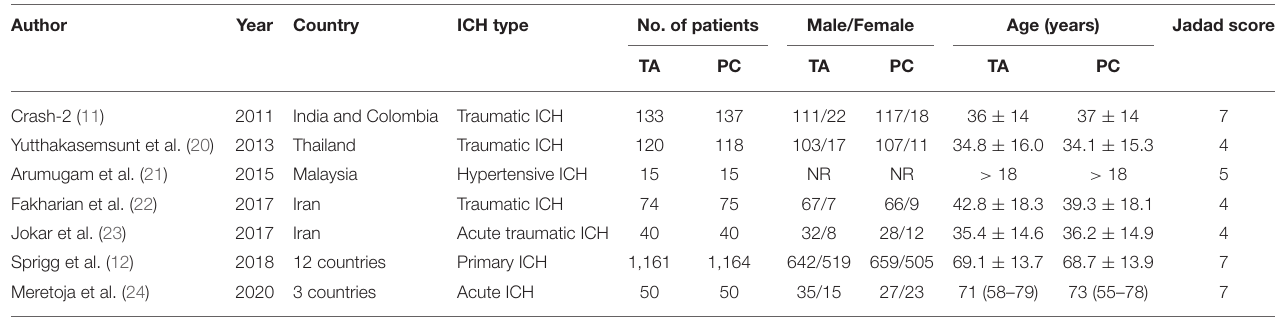
TABLE 1 | Characteristics of the included